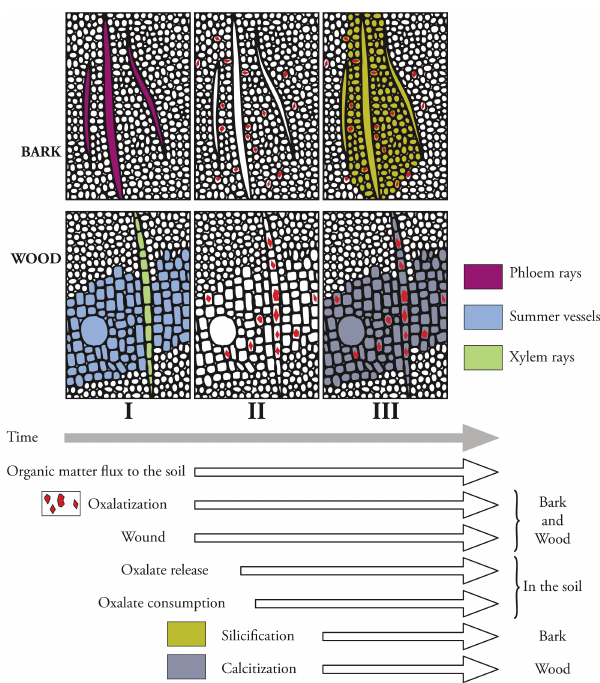
Fig. 6. Temporal occurrence of major events often observed related to the iroko oxalate-carbonate pathway. Three steps can be distin- guished: Step I: “initial” state before any noticeable event happen- ing to the seedling. Step II: Oxalatization is the first step observed related to both photosynthetic activity and concomitant organic mat- ter flux to the soil. Whewellite is synthesized in the bark and the wood tissues. If wounds occur on the trunk, oxalotrophic bacteria contamination can initiate oxalate consumption. However, this pro- cess seems minor and the process becomes really efficient only after the release of a large amount of oxalate crystals into the soil. This last step requires an important flux of Ca-oxalate-bearing organic matter. At this stage, the process can be enhanced through termite feeding and saprophytic fungi. In the soil, oxidation of calcium ox- alate by soil oxalotrophic bacteria starts and leads to the release of carbonate ions. Step III: these ions, present in the soil parent so- lution (i.e. as DIC), are pumped through the roots and can locally precipitate as calcium carbonate in the wood tissues (in the vascular system, or as a calcite pseudomorphosis on neighbouring tree tis- sues). Silicification is interpreted as synchronous to calcitization. Nevertheless, it remains unclear if amorphous silica appears after